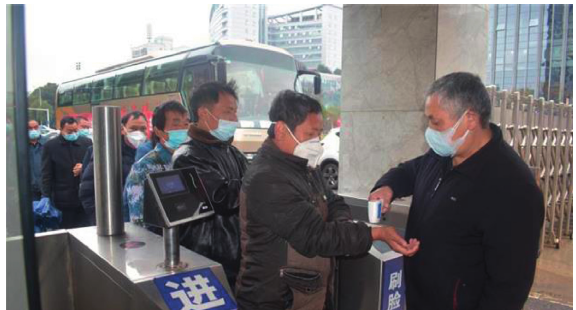
Figure 6: Checking the body temperatures of workers before they enter into the construction site in Case 12 (source: http://www.